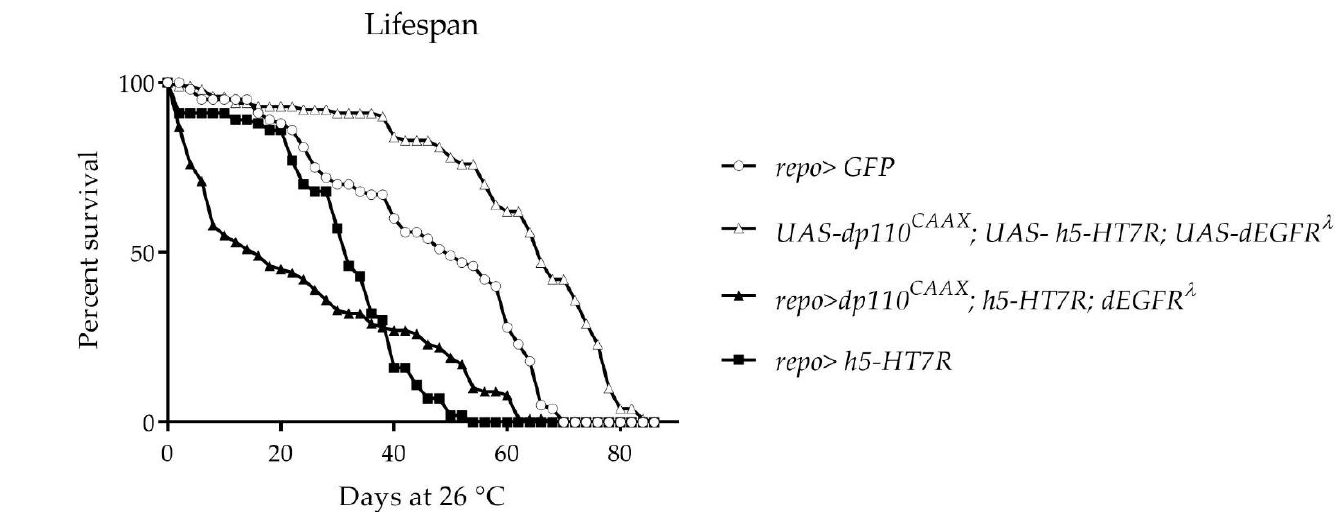
Figure 4. Lifespan of escaper flies. Results correspond to the percentage of living flies repo>dp110 CAAX ; h5-HT7R; dEGFR λ as a function of time at 26 °C. Lifespan of controls correspond- ing to the driver repo>GFP alone and UAS-h5-HT7R or UAS-110 CAAX , h5-HT7R; dEGFR λ alone is also shown .